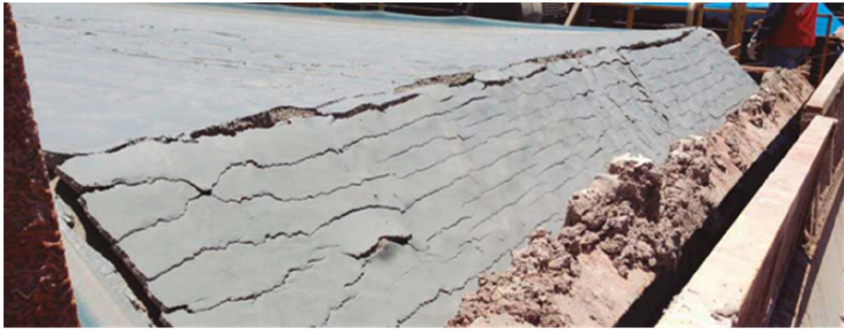
Figure 9. Filtered Tailings Technology—Tailings Filters at Mantos Blancos Mine Chile [11].